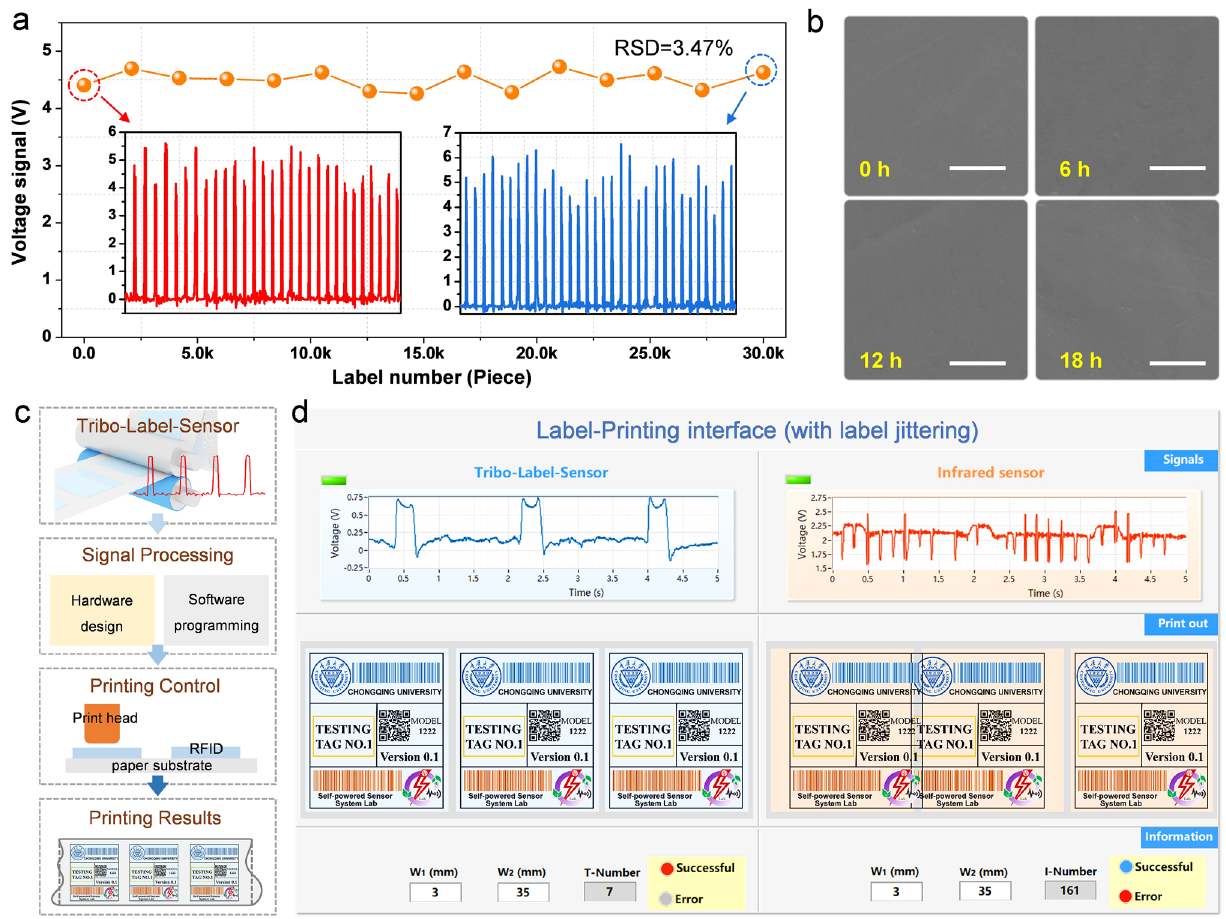
Fig. 4 Demonstration of application feasibility of TLS. a Long-term stability of TLS after 30,000 cycles. The insets show the detailed sens- ing signal at the initial and final stage. b Surface morphology of the FEP film after operating for 0, 6, 12, and 18 h. c Schematic diagram of the workflow of a label printer based on TLS. d Label printing demonstration using TLS and infrared sensor based on the LabVIEW virtual plat-